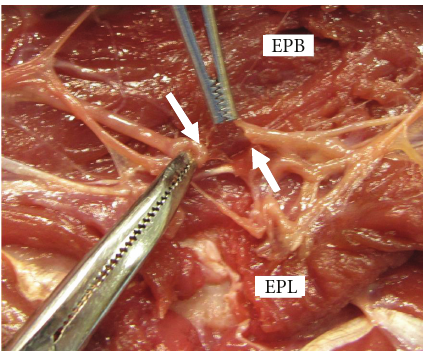
Figure 6: Cadaveric gross dissection with laceration injury recre- ated showing cut extensor carpi ulnaris (ECU), extensor pollicis longus (EPL), and white arrows indicate cut branch of posterior interosseous nerve (PIN) to extensor pollicis longus